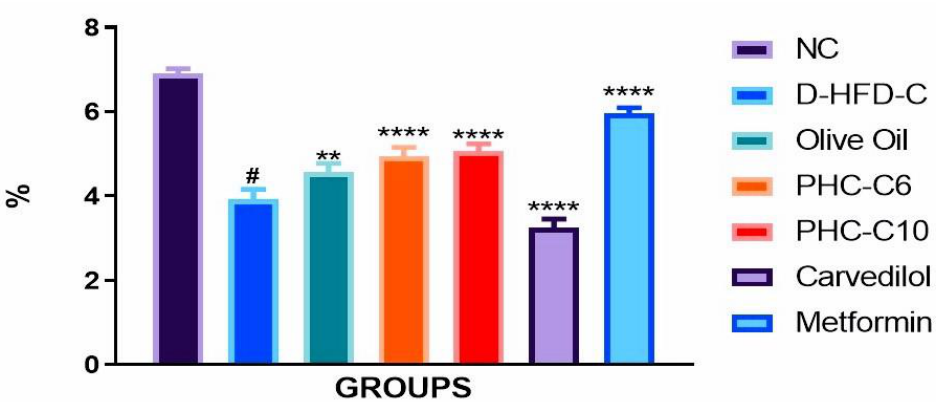
Figure 2. All values are expressed as mean ± SD ( n = 6) analyzed by one-way ANOVA followed